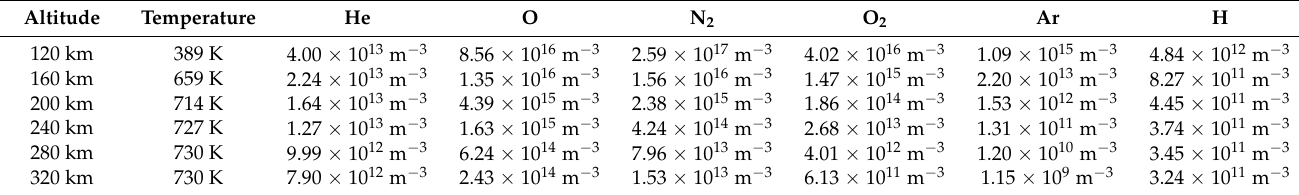
Table 5. Background atmospheric temperature and numerical density of various molecules at different altitudes under low F10.7 and medium Ap environments (LM).